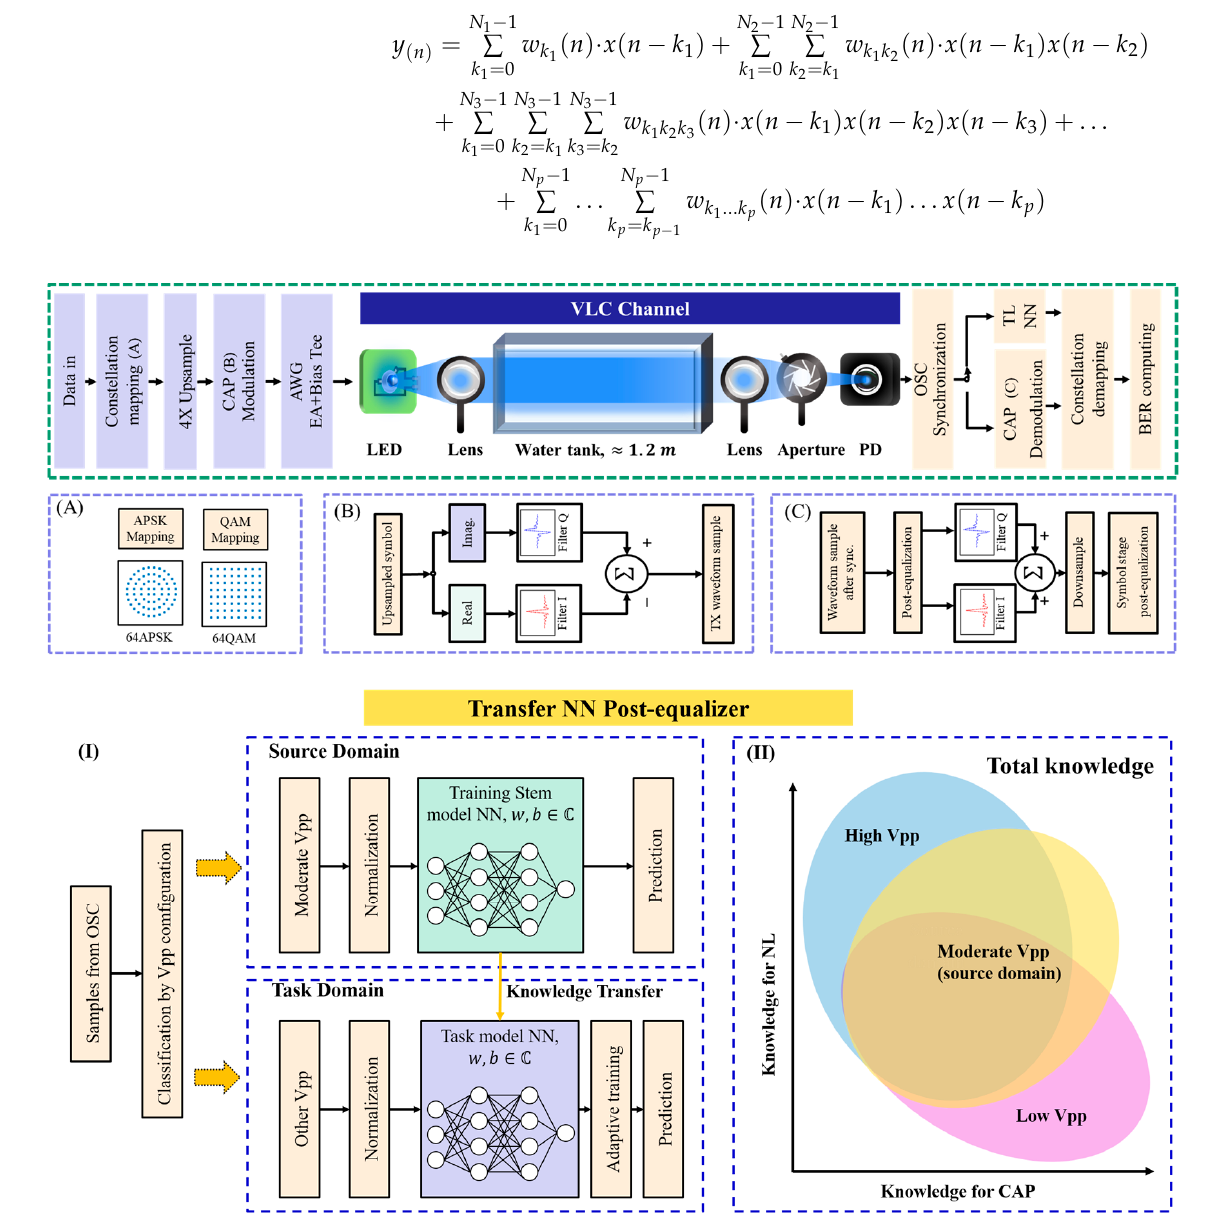
Figure 1. Upper part: block diagrams for the underwater VLC system. ( A ) The two choices for constellation mapping to generate the I and Q channels for CAP; ( B ) conventional modulation method for CAP; ( C ) conventional demodulation method for CAP. Lower part: transfer learning strategy proposed in this article. ( I ) The models are developed from a ‘stem model’ trained from the ‘source domain’. ( II ) A Venn diagram showing the knowledge distribution in data sets from different Vpp configurations. There is a trade-off between the knowledge for CAP demodulation and the nonlinear distortion. However, a moderate Vpp configuration would reach a balance between the two and, thus, is the best candidate for source